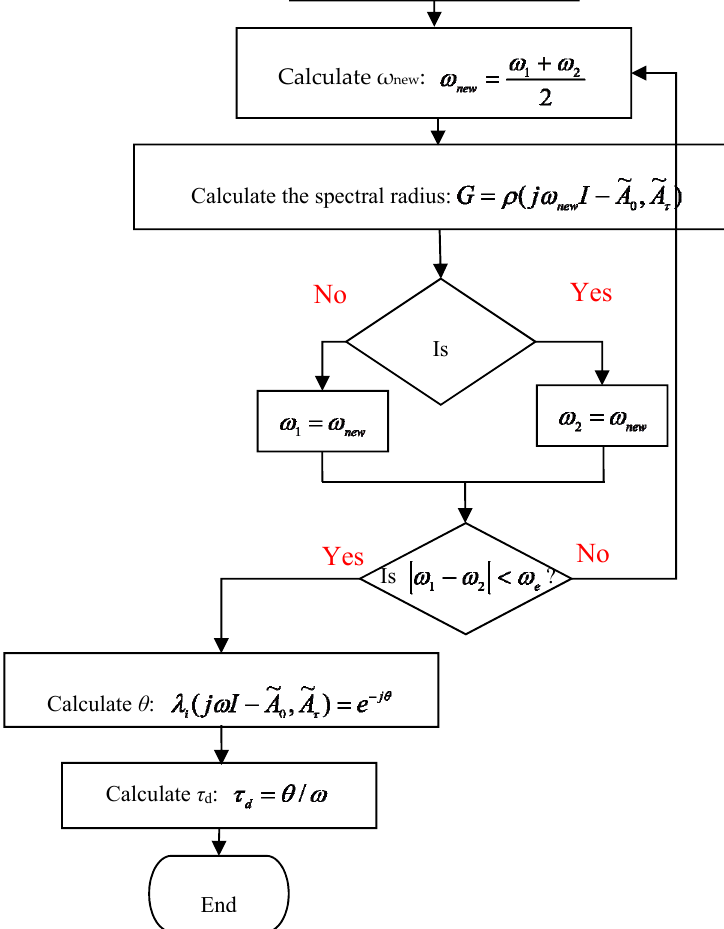
Figure 6. The delay margin computation algorithm.